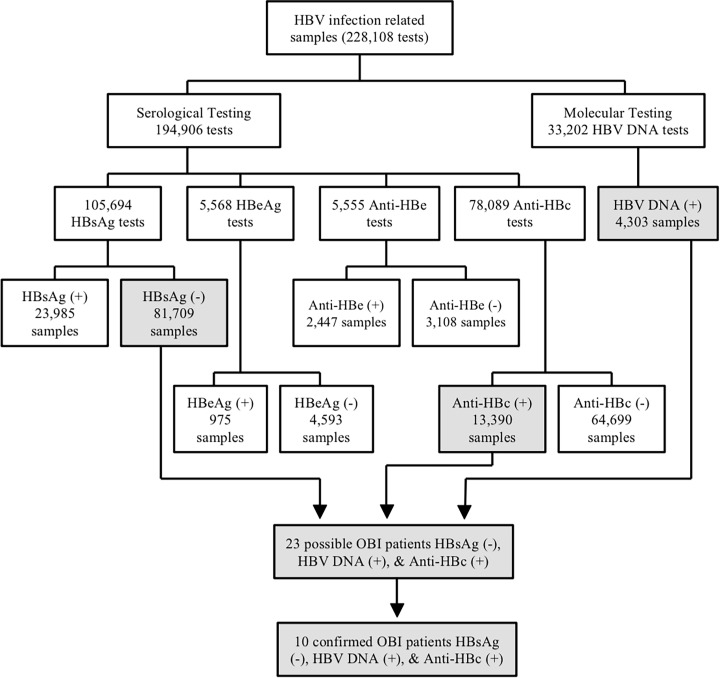
HBV infection related tests conducted by SEALS from the January 1st 2007 – March 15th 2013.From January 2007 until March 2013, SEALS at POWH conducted 228, 108 tests that were related to HBV infection. Of the 105, 694 samples tested of HBsAg, 81,709 were negative while 21,985 tested positive. There were 5,568 HBeAg samples tested. Nine hundred seventy-five samples were HBeAg positive while 4,593 were HBeAg negative. Additionally, out of the 5,555 anti-HBe tests, 2,447 samples were positive and 3,108 were negative. Of the 78,089 samples tested for anti-HBc, 64,699 were negative while 13,390 samples were positive. Lastly, 4,303 out of 33,202 samples tested for HBV DNA were positive. From these tests, 23 patients were possible OBI. However, only 10 patients were in compliance with the study criteria (HBsAg negativity, HBV DNA and anti-HBc positivity) that comprised out study cohort.